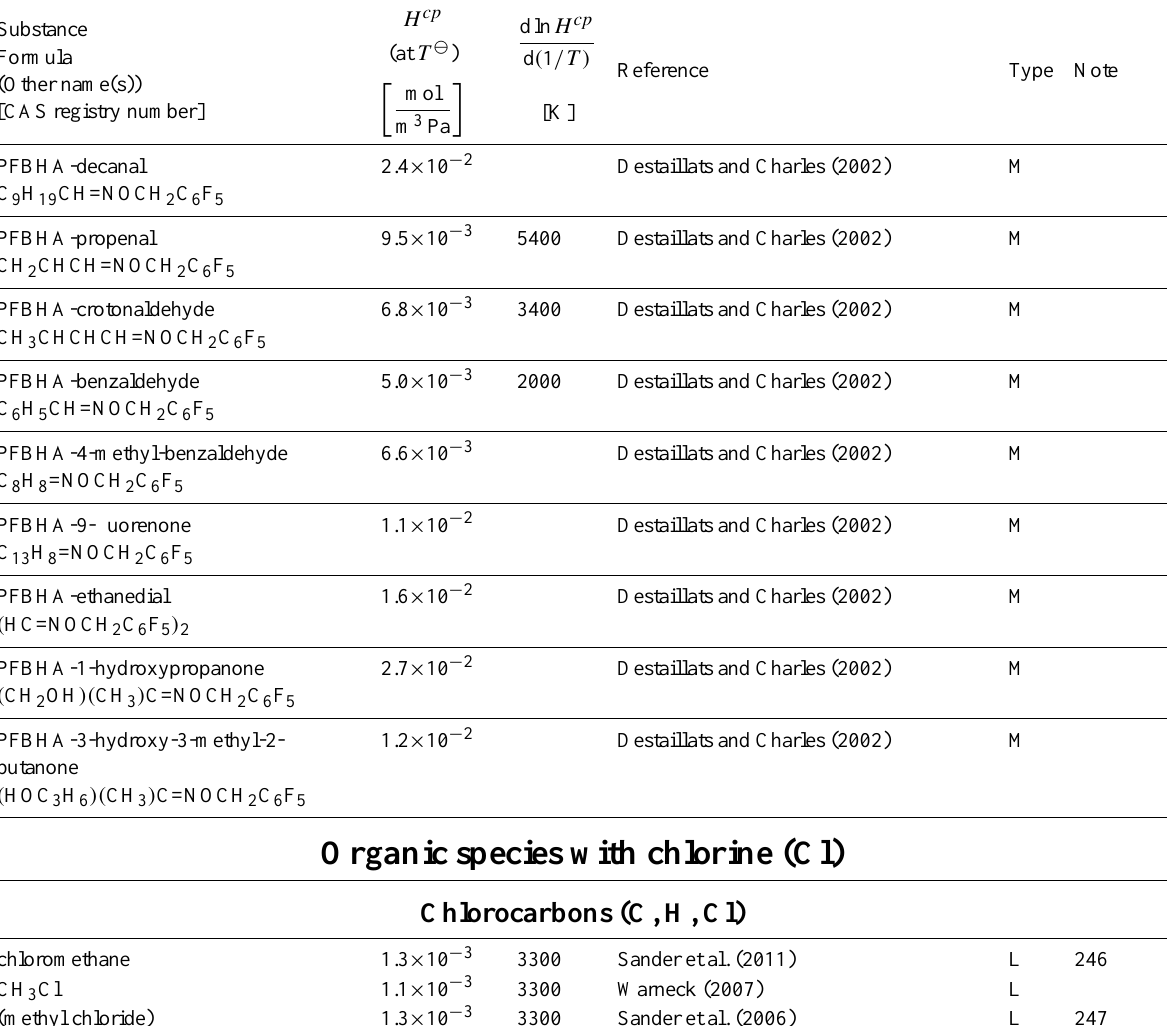
Table 6: Henry’s law constants for water as solvent